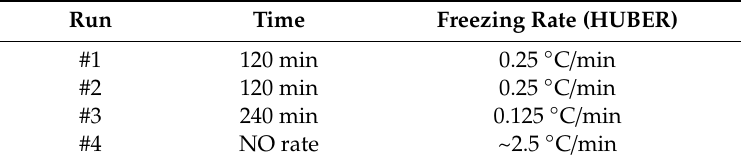
Table 1. Freezing setpoints of the Huber thermostat for given experiments.